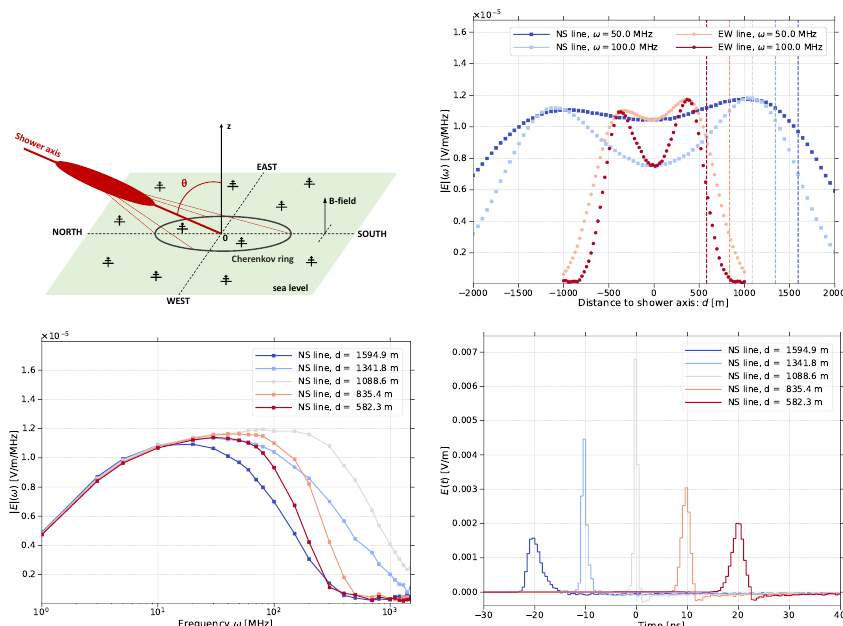
Figure 3. ZHAireS simulations of the electric field emitted in a shower developing in the atmosphere induced by a primary proton of energy 10 18 eV at zenith angle θ = 70 ◦ . Top left panel: Shower geometry: The shower arrives from the North to the ground located at sea level (green plane). Observers (antennas) are placed along the North-South (parallel to the projection of the shower axis on the ground) and East-West directions indicated with dotted lines. The magnetic field used in the simulations has an intensity of B = 50 µ T and an inclination angle = − 90 ◦ (i.e., it is perpendicular to the ground). Also drawn in red are a few rays emitted at shower maximum in the Cherenkov direction making a cone. The ellipse shown is the intersection of the cone with the ground. Top right panel: Modulus of the electric field at two frequencies for observers at different positions. Positive coordinates correspond to antenna positions located North (or East) of the origin at impact point O shown in the top panel, in this example at sea level. Bottom left: Frequency spectrum of the modulus of the electric field at five different positions along the NS line indicated by the vertical dashed lines in the right top panel. An observer at d (cid:39) 1088 m sees X max at the Cherenkov angle, and the spectrum extends well into the GHz frequency range. Bottom right: Electric field as a function of time for the same observers as in the bottom left panel displaying bipolar pulses. The pulses have been arbitrarily shifted in time for better